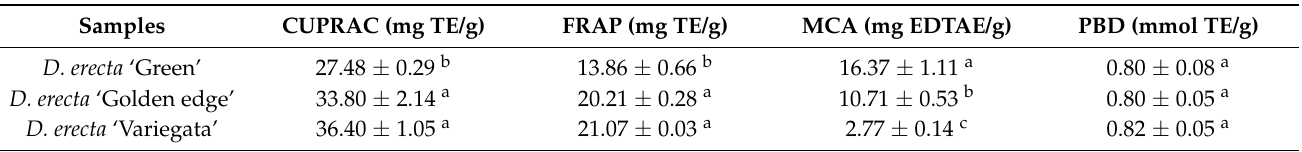
Table 3. Reducing abilities, metal chelating, and total antioxidant ability (by phosphomolybdenum assay) of the tested